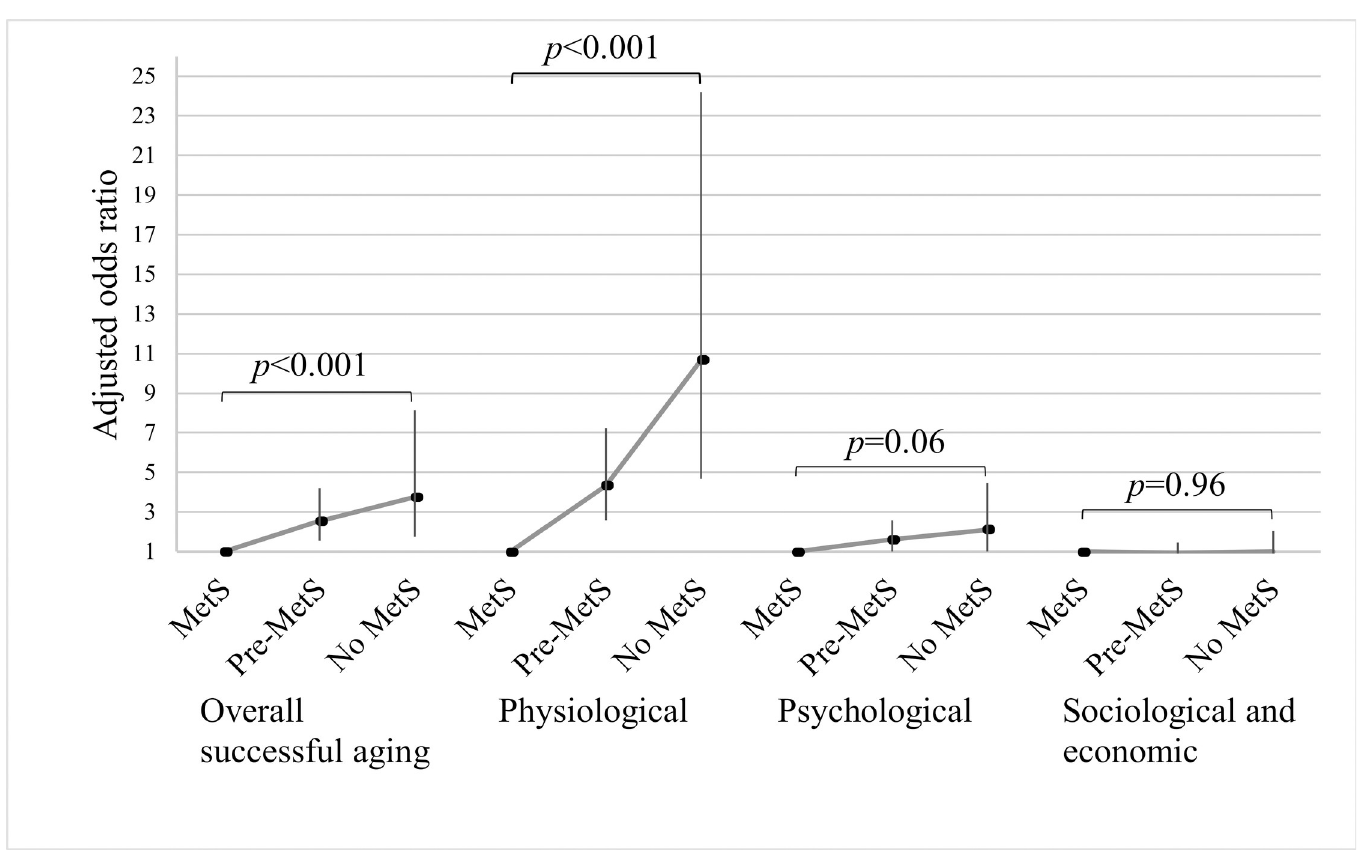
Fig 2. Adjusted odds ratio and 95% confidence interval for the association between MetS status and successful aging. Abbreviations: MetS, metabolic syndrome; Ref., reference; GLMM, generalized linear mixed model. GLMM model: Successful aging~ MetS status+ Age+ Sex+ Years of education+ Alcohol+ Time+ MetS status × time. The p values compared the differences across MetS status [no MetS, pre-MetS, and MetS